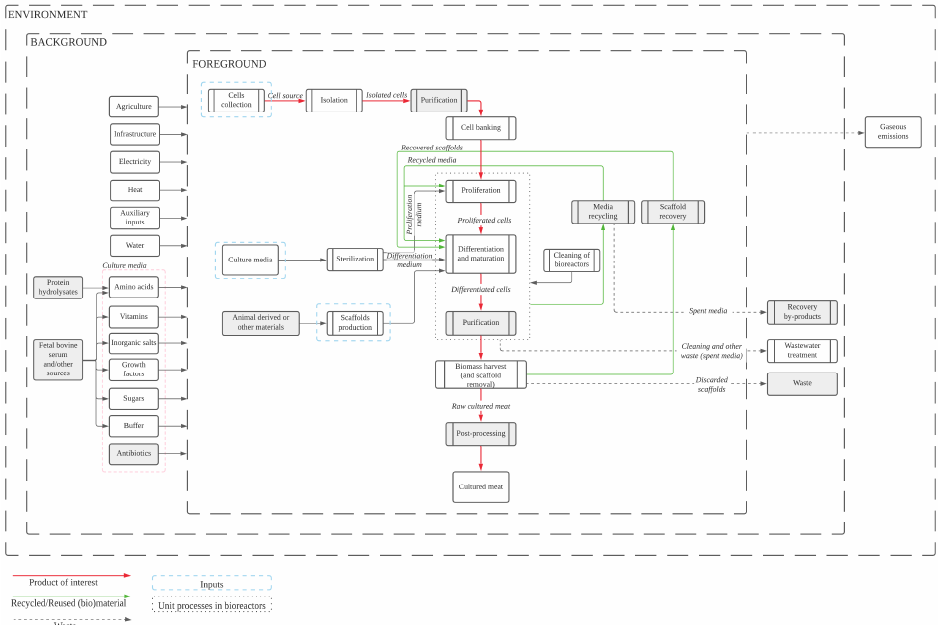
Figure 2. Process scheme proposal for future life-cycle assessments of cultured meat. Foreground system includes the core processes in the production of cultured meat, which will be quantified by the user. Background processes can be documented based on existing market data. Grey boxes indicate when the process can be excluded or when more than one option is possible. Boxes with single borders represent materials and biomaterials, while boxes with double borders represent unit processes.